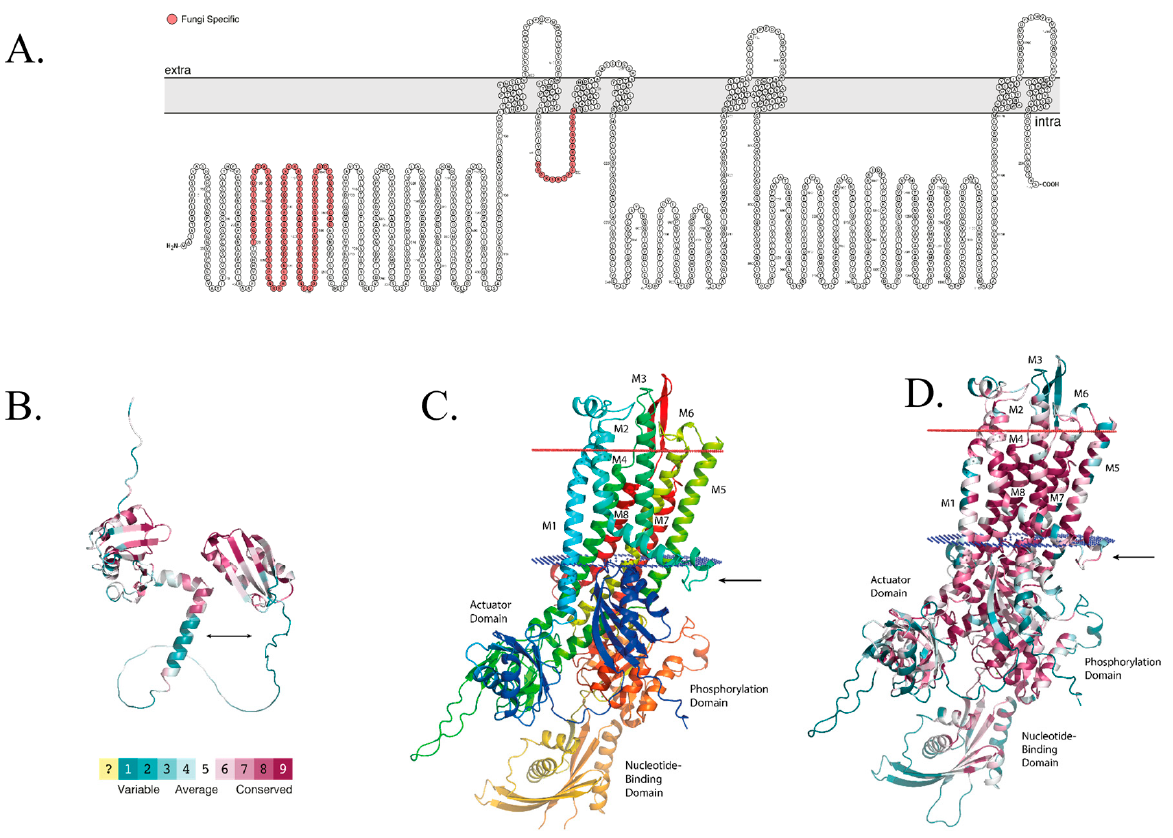
Figure 1. Model Structure of A. fumigatus CrpA. ( A ) A two-dimensional schematic representation of A. fumigatus CrpA topology. Membrane helices are numbered 1 to 8, and the fungal-unique regions CrpA N-terminal domain (amino acids 1 to 285) and intracellular loop (residues 542–556) are highlighted in red. ( B ) A model structure of the A. fumigatus CrpA N-terminal domain (amino acids 1 to 285) constructed with AlphaFold and colored on the basis of ConSurf evolutionary conservation analysis with cyan-through-maroon representing variable-through-conserved positions. The unique Aspergillus genus region (residues 90–200) is marked with black arrows. ( C ) A model structure of the A. fumigatus CrpA C-terminal part (amino acids 285 to 1254) constructed with AlphaFold. The (inferred) extracellular and intracellular leaflets of the membrane are depicted as red and blue discs, respectively. The orientation of CrpA in the membrane was modeled on the basis of the orientation of one of its closest homologs with a known structure, the bacterial Legionella pneumophila CopA. The intracellular loop unique to CrpA that connects helices M2 and M3 (residues 542–556) is marked with an arrow. ( D ) A model structure of the A. fumigatus CrpA C-terminal region, colored on the basis of ConSurf conservation analysis as in ( B